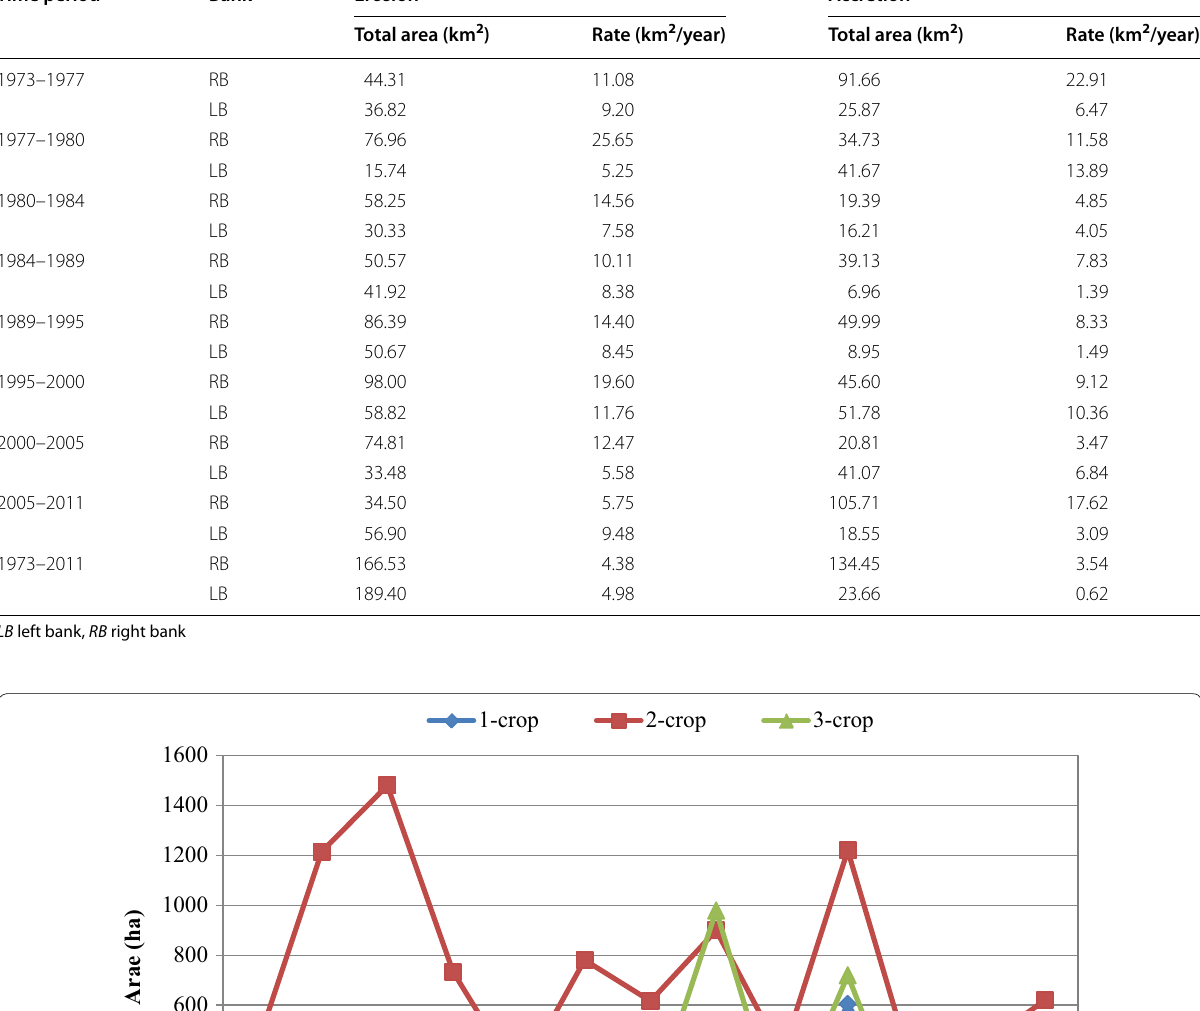
Table 2 Erosion and accretion areas along banks of the Padma River during 1973–2011. Source: Dewan et al. (2017) Time period